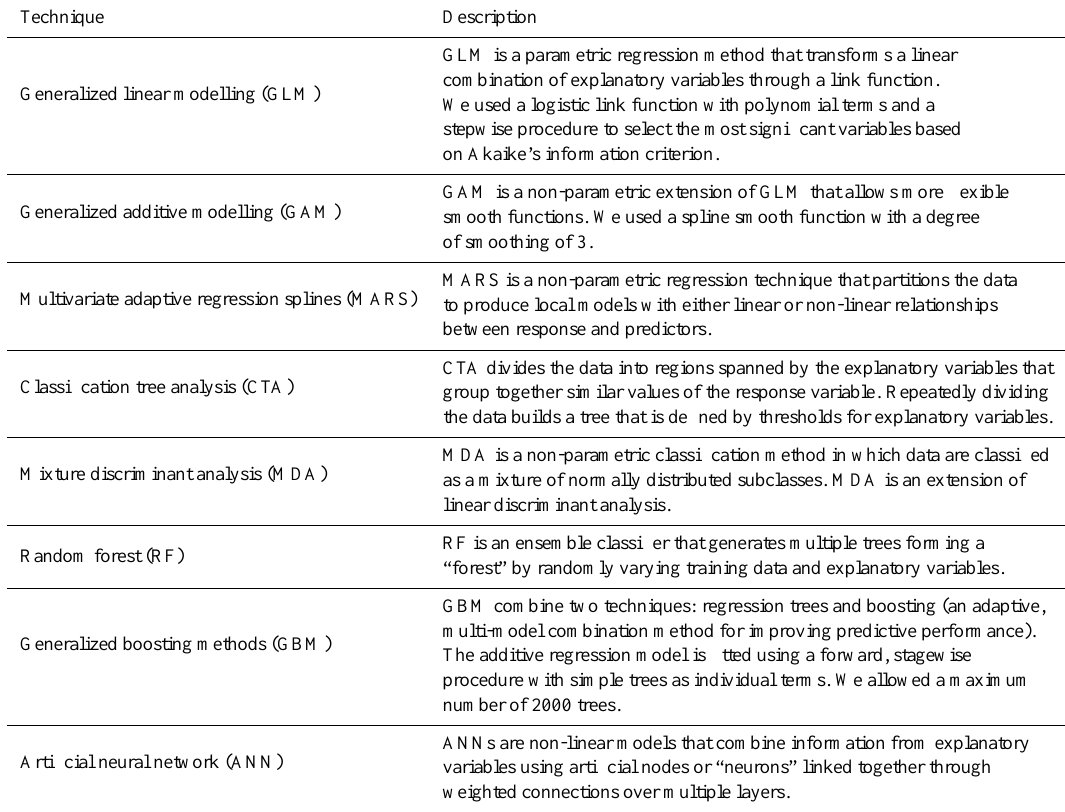
Table 1. Description of climatic envelope modelling techniques (based on Fronzek et al., 2006; Heikkinen et al., 2006; Elith et al., 2008; Marmion et al.,